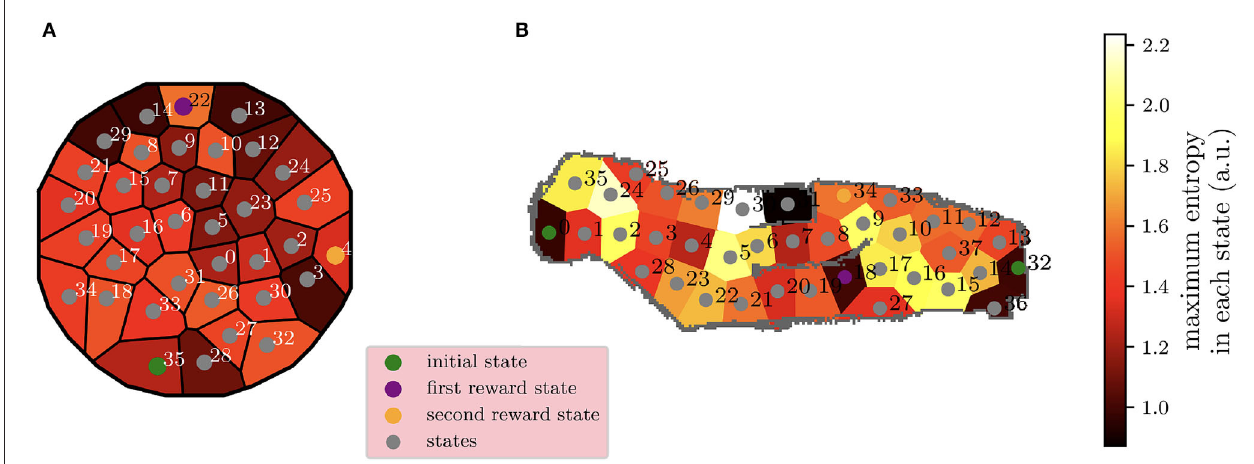
FIGURE 10 | Representation of the navigation environments for the previous experiments, Section 3 and Section 4, organized in, respectively, 36 and 38 discrete Markovian states decomposed from the data acquired during the autonomous navigation of the robot, when no reward was present in the mazes. The initial and reward states for the tasks are also highlighted in the figure. In these heatmaps, the lighter the color of the state, the greater the maximal entropy of that specific state, according to Equation 5. The represented scale of entropy values (0.87–2.23 a.u.) has been selected to cover the whole range of the computed entropies. Moreover, in both environments, the robots have navigated for 5357 actions. (A) In the case of the circular maze (Section 3), the navigation and the transition model are acquired after simulated navigation on ROS Gazebo. (B) In the second experiment (Section 4), the navigation and the transition model are instead computed after the real robot navigation, which generated a wider range of maximal entropy values, sometimes also very low due to the presence of walls that categorically constrained certain states of the